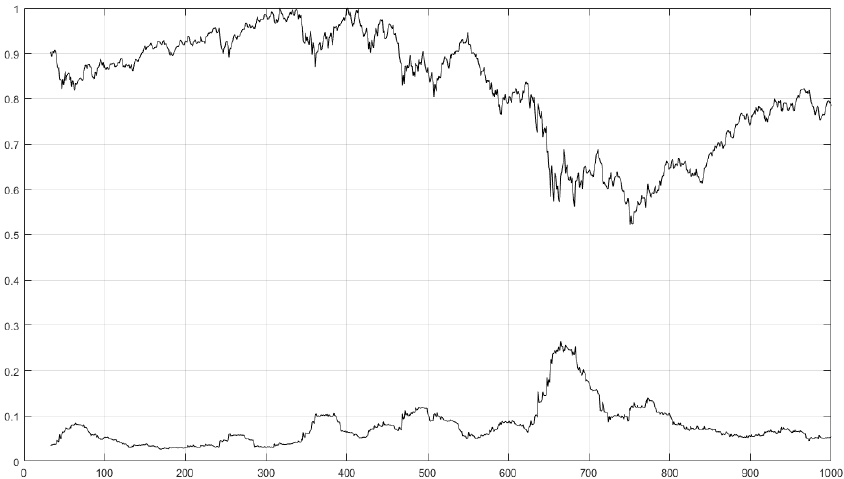
Figure 5. Example of computing the time dependent volatility (lower signal) using Equation (25) for a normalised financial signal (upper signal) with a look-back window of N =